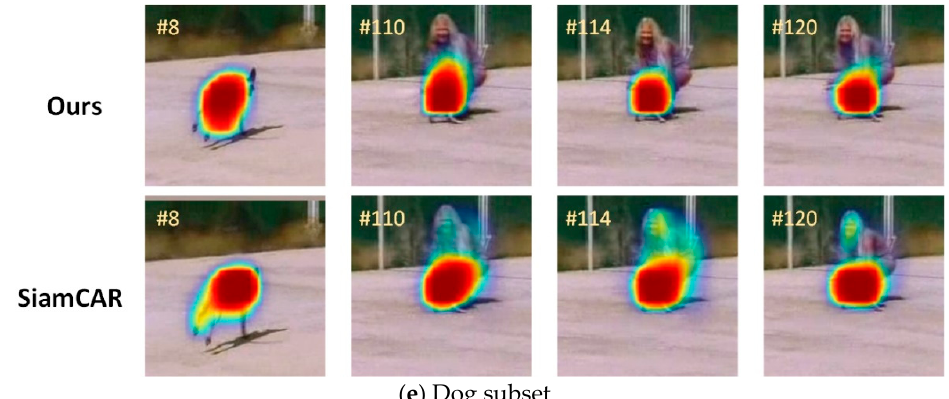
Figure 14. The heat map experiment visual results correspond to 5 scenes, including ( a ) blot subset; ( b ) box subset; ( c ) cardark subset; ( d ) crowds subset; ( e ) dog subset.